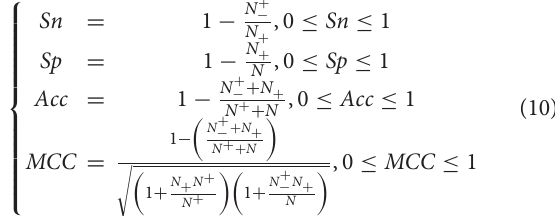
Frontiers in Cell and Developmental Biology |